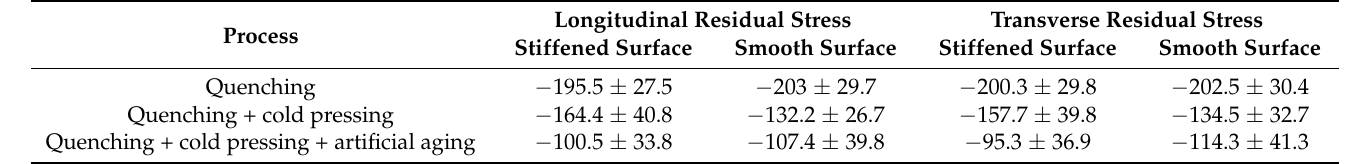
Figure 9. Residual stress distribution of cold pressed T-type rib: ( a ) path ab; ( b ) path cd (depicted in Figure 3).